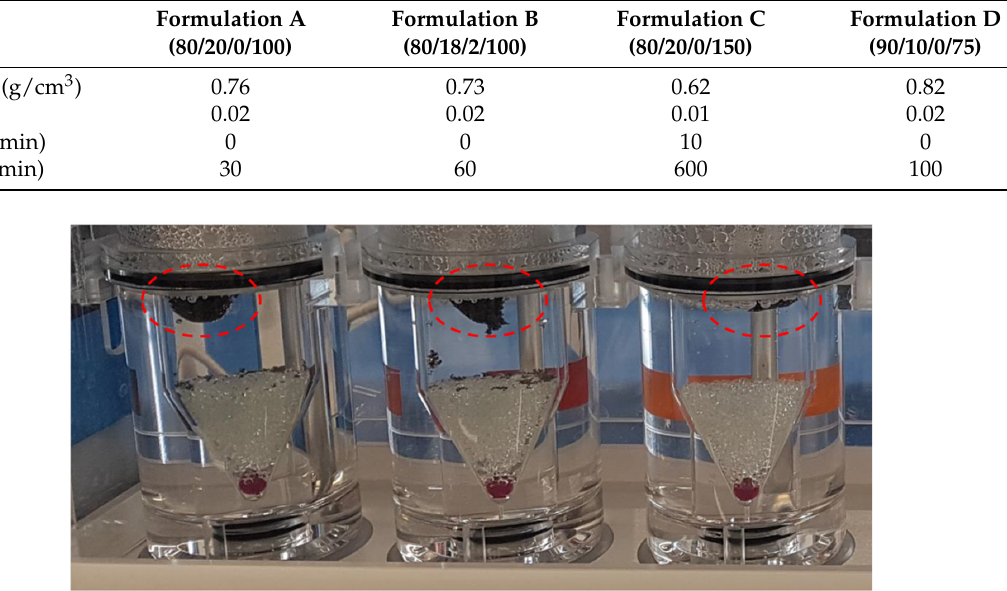
Figure 8. The mean release profiles ( n = 3) of Met from printlets in the USP4 apparatus. Table 2. Mean apparent density of formulations obtained by SLS ( n = 10) and results of buoyancy For all formulations, the mean apparent density was lower than 0.8 g/cm 3 (Table 2). observations in Apparatus 4. The porous structure of the printlets ensured their immediate flotation after the filling of